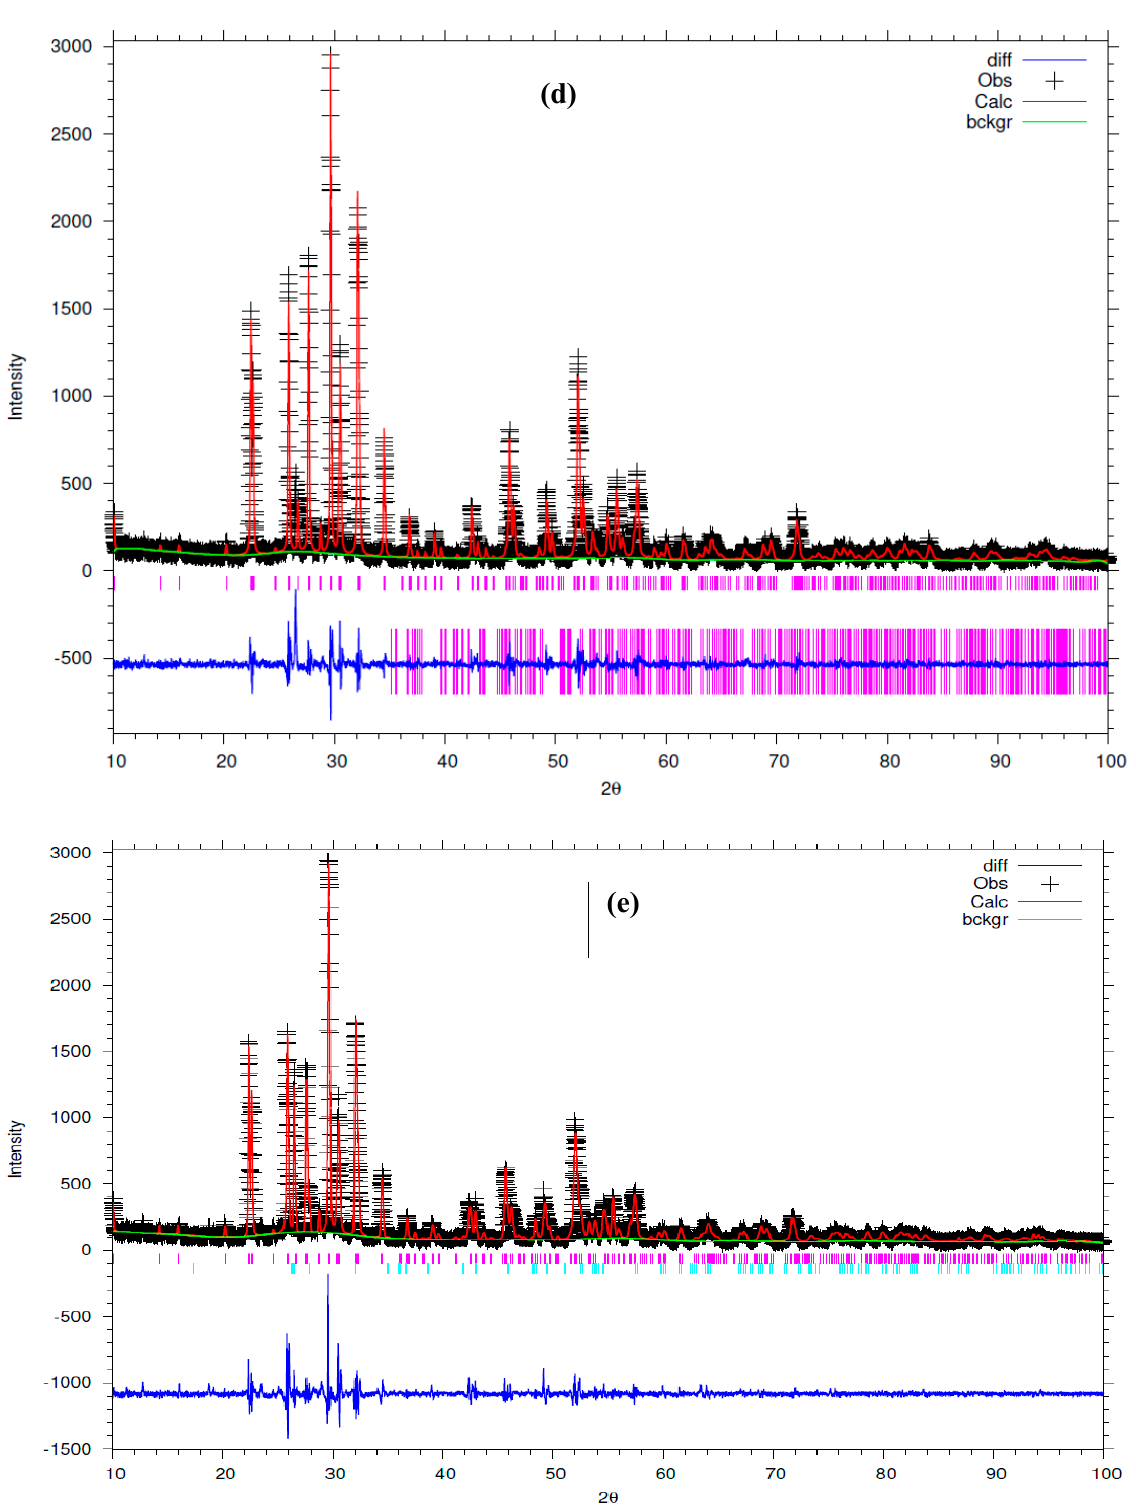
Figure 1. Combined X − ray diffraction patterns ( a , b ) and Rietveld refinement of Ba 0.54 Na 0.46 Nb 1.29 W (0.37 − x) Mo x O 5 ceramics (x = 0.04 ( c ), x = 0.08 ( d ), and x = 0.33 ( e )).